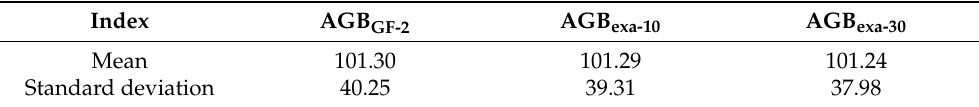
Table 7. Accuracy of the scale error corrected AGB at various spatial resolutions.